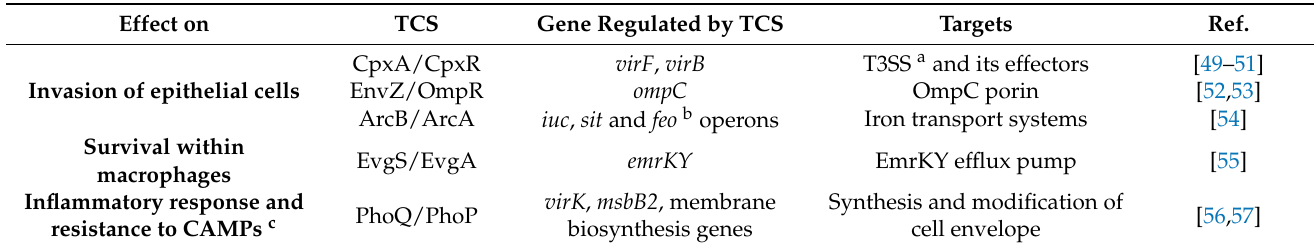
Table 2. TCSs contributing to Shigella